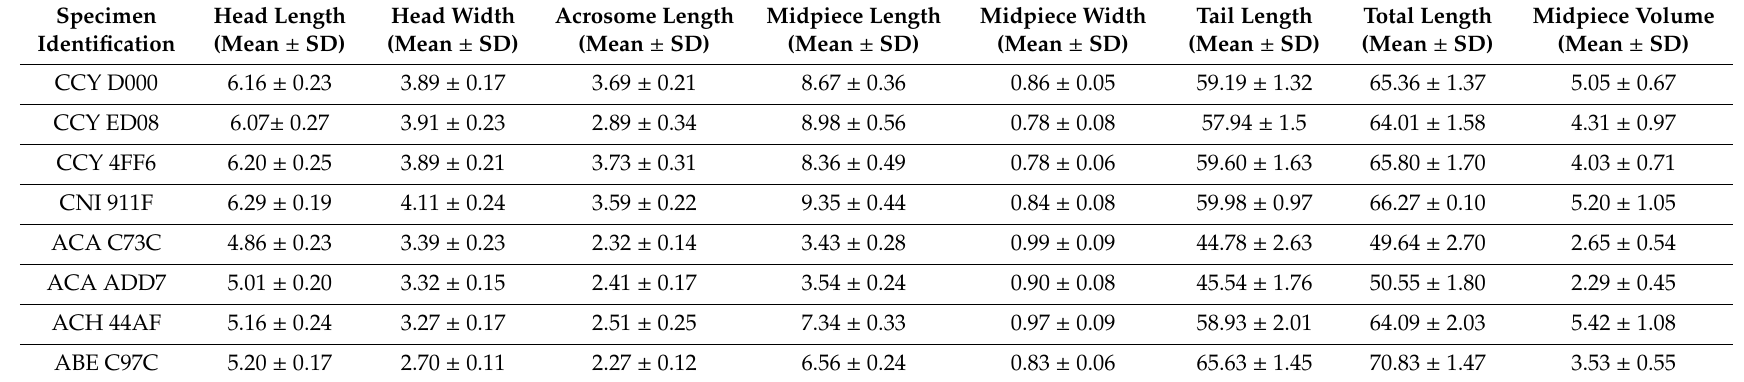
Table 1. Measurements on spermatozoa of each individual of the analyzed neotropical primate species.